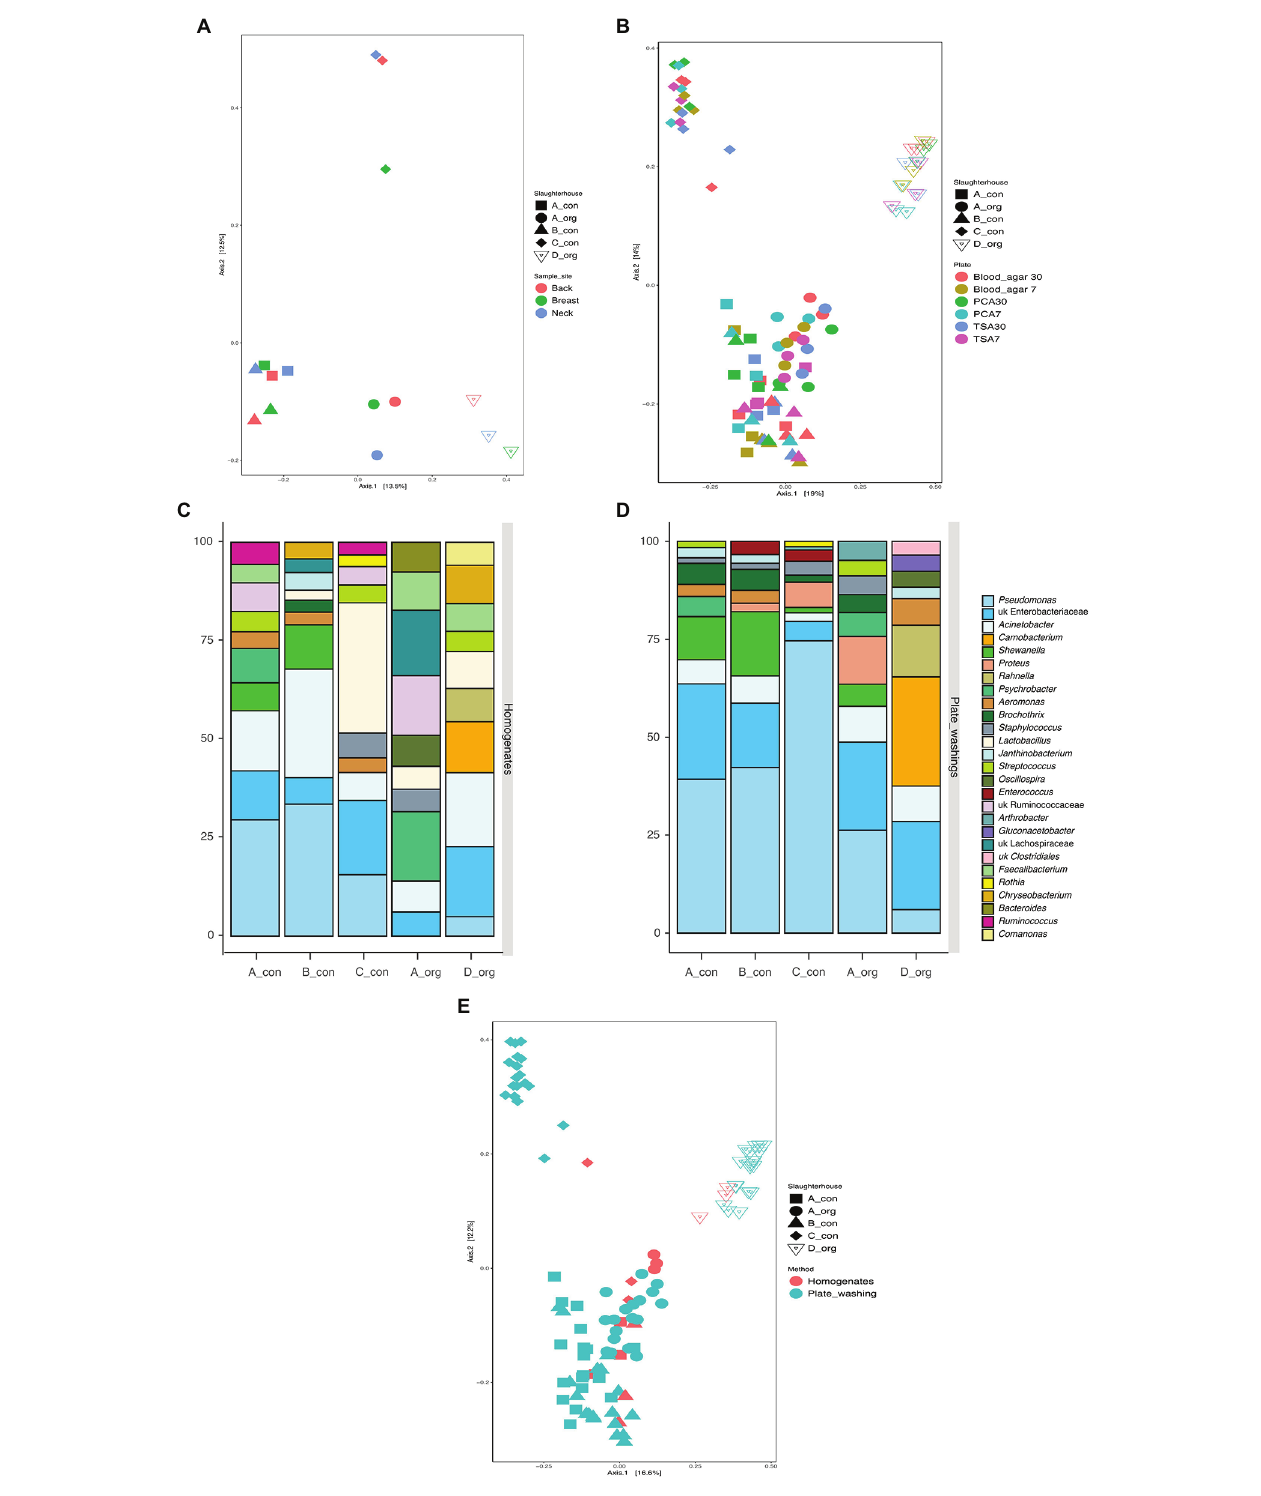
FIGURE 3 | The similarity of bacterial communities between groups of samples. (A,B) Comparison of the influence of slaughterhouses (both), sampling areas (A) , and isolation plates (B) ; (C,D) top 10 abundant bacteria on carcasses processed in each slaughterhouse using homogenates (C) and plates washing amplicon (D) sequencing (only top 10 taxa present in each bar); and (E) principal coordinate analysis (PCoA) for all samples examined using 16S amplicon